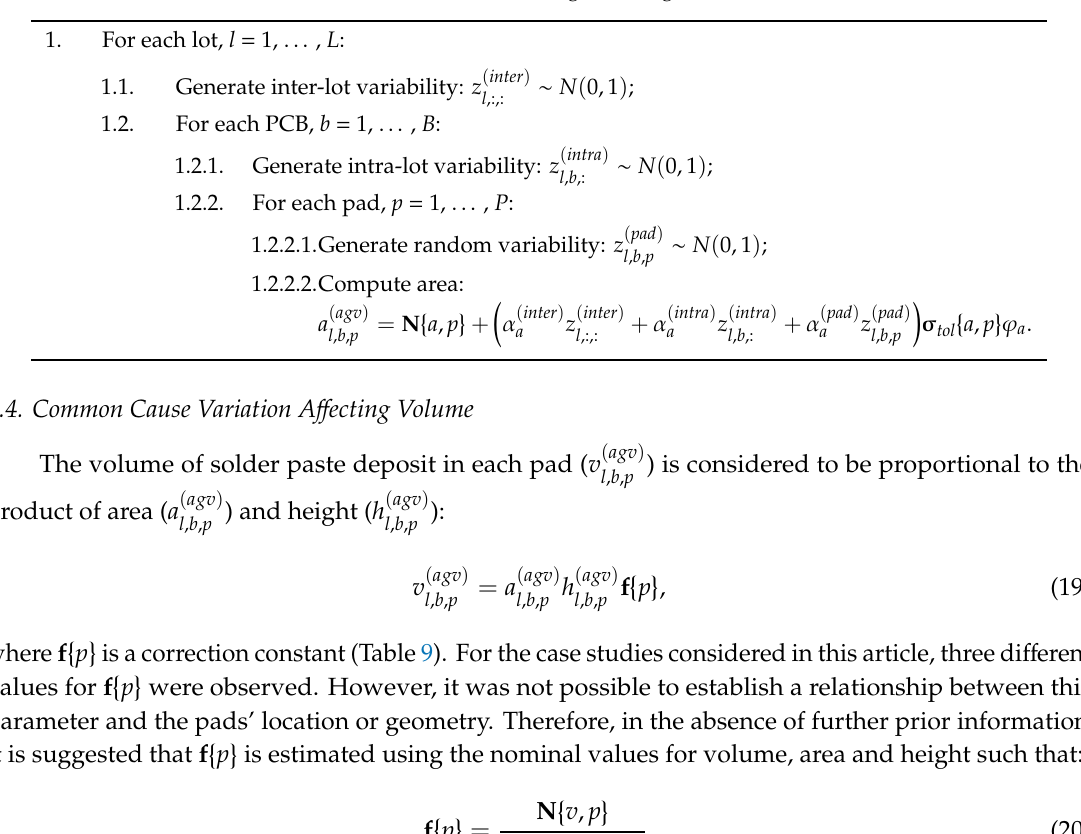
Table 8. Pseudo-code for generating the area.